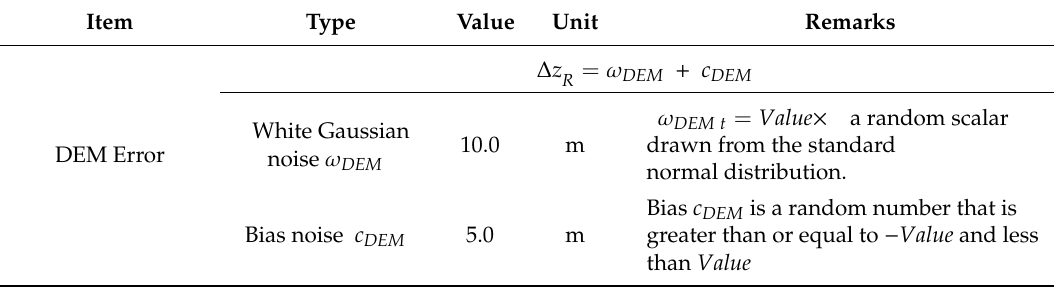
Table 6. Overview of DEM error used in the simulation.